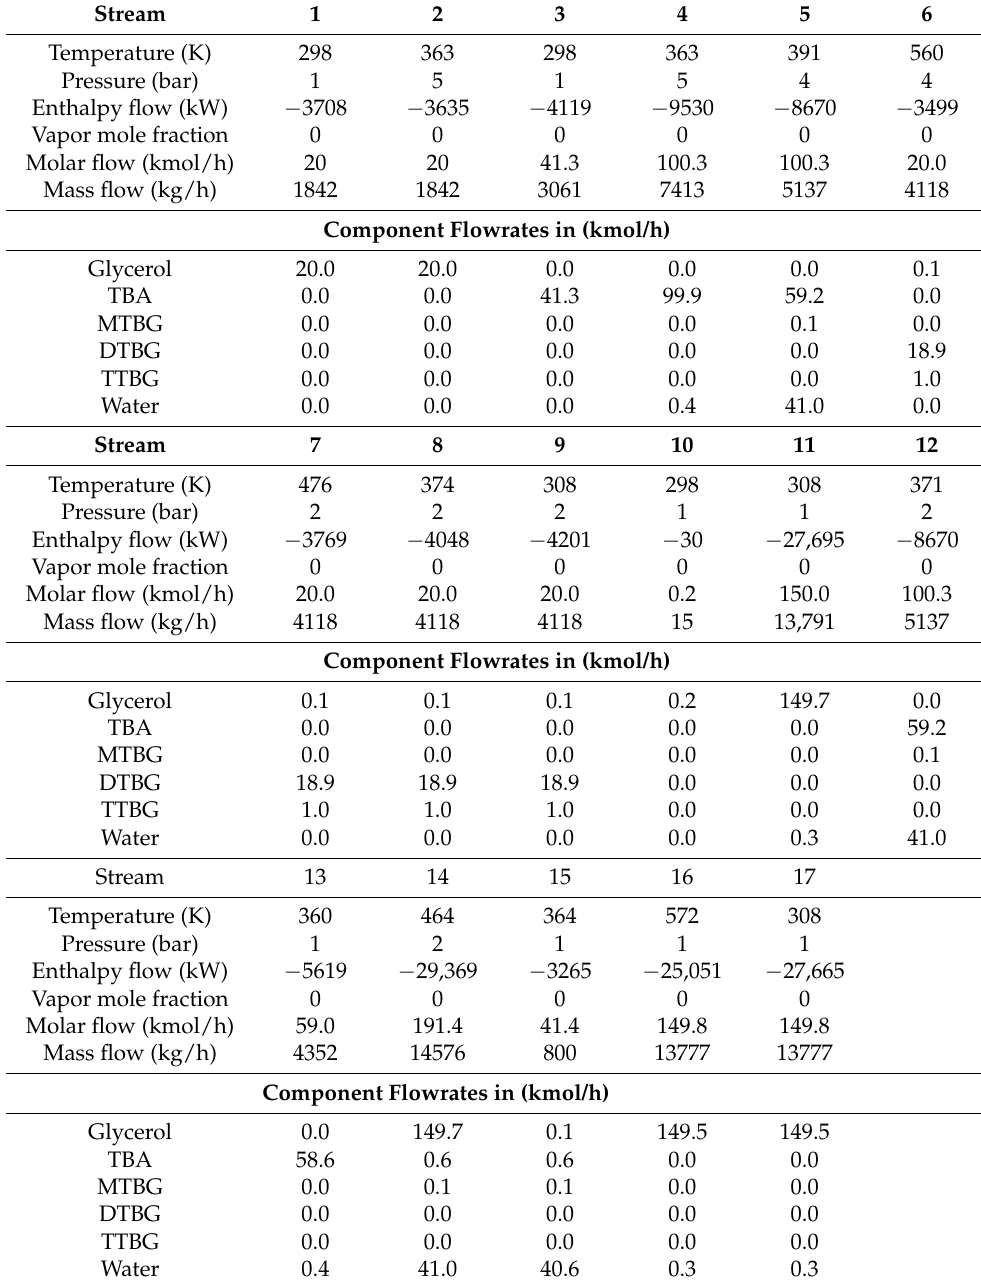
Table 6. Stream information of the integrated glycerol etherification